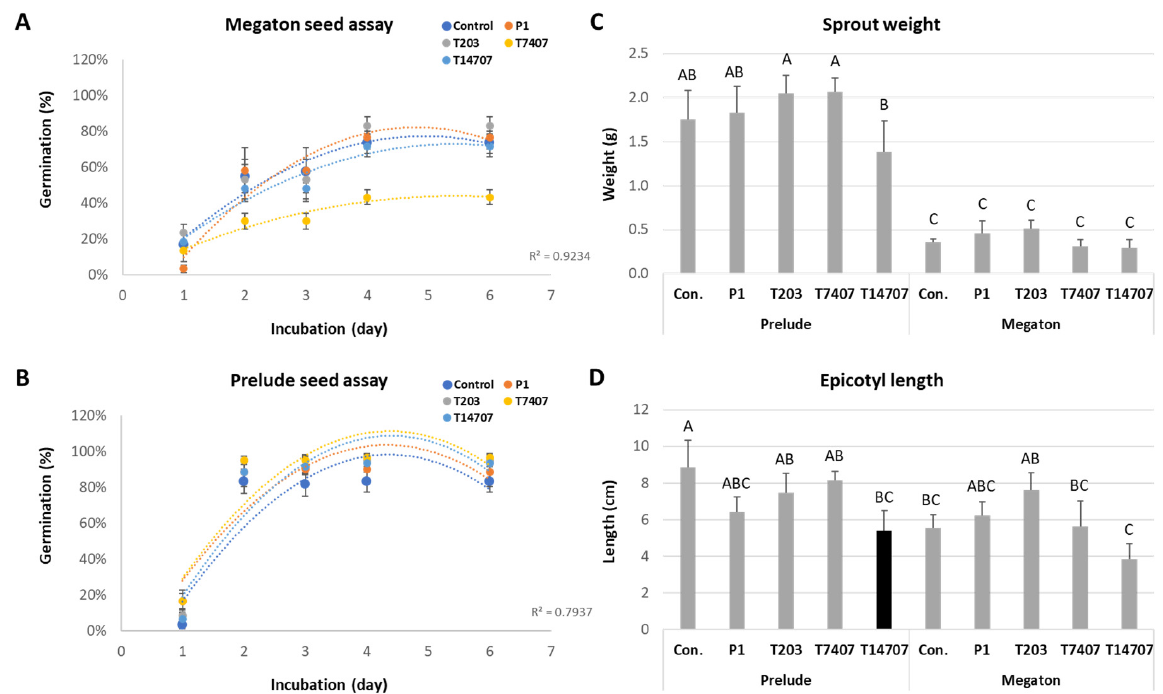
Figure 4. Seed assay for detecting the possible sensitivity to the biological treatments. The sweet corn Megaton (Limagrain, Saint-Beauzire, Puy-de-Dôme, France, marketed by Hazera Seeds Ltd.) and Prelude (SRS Snowy River Seeds, Australia, provided by Green 2000 Ltd., Bitan Aharon, Israel) cultivars were tested for susceptibility to Trichoderma treatments. The test was conducted in Petri dishes with wet Whatman paper at 28 ± 1 °C for one week in dark conditions. The seeds were dipped in the Trichoderma spp. (Table 1) growth media for six hours. Germination of the seeds of Megaton cv. ( A ) and Prelude cv. ( B ) was documented 0–6 days post-treatment (the only significant statistical difference from the control at p < 0.05 was found in the T7407 ( T. longibrachiatum ) treatment in the Megaton cv. test). The wet weight of the sprouts ( C ) and epicotyl length ( D ) were measured on day 6 of incubation. The experiment was performed in 5–6 biological repetitions. Error bars indicate standard error. Different letters (A–C) above the chart’s bars represent an ANOVA test significant difference ( p < 0.05).